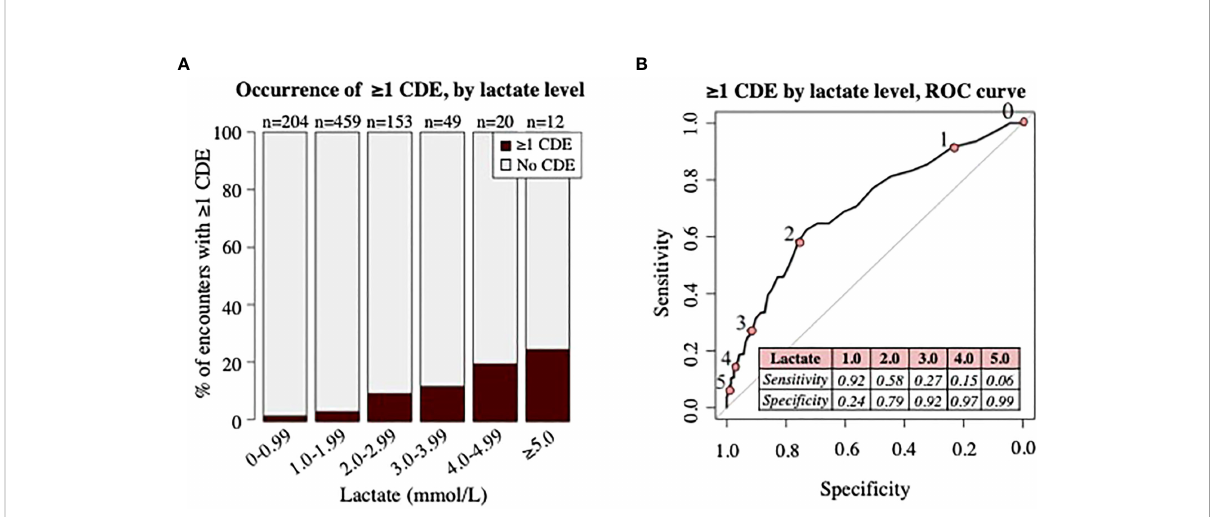
FIGURE 3 Analysis of clinical deterioration events (CDE) by lactate level. (A) Proportion of patient encounters with occurrence of ≥ 1 CDE by lactate level in increments of 1mmol/L. Numbers (n) on top of bars signify the total number of patient encounters with initial lactate level in speci fi ed range. (B) ROC curve demonstrating association of lactate level with occurrence of ≥ 1 CDE. Numbers 0-5 along ROC curve represent ROC curve points for lactate level cutoffs (pink circles) in mmol/L, shown in the table. Area under the curve = 0.704.